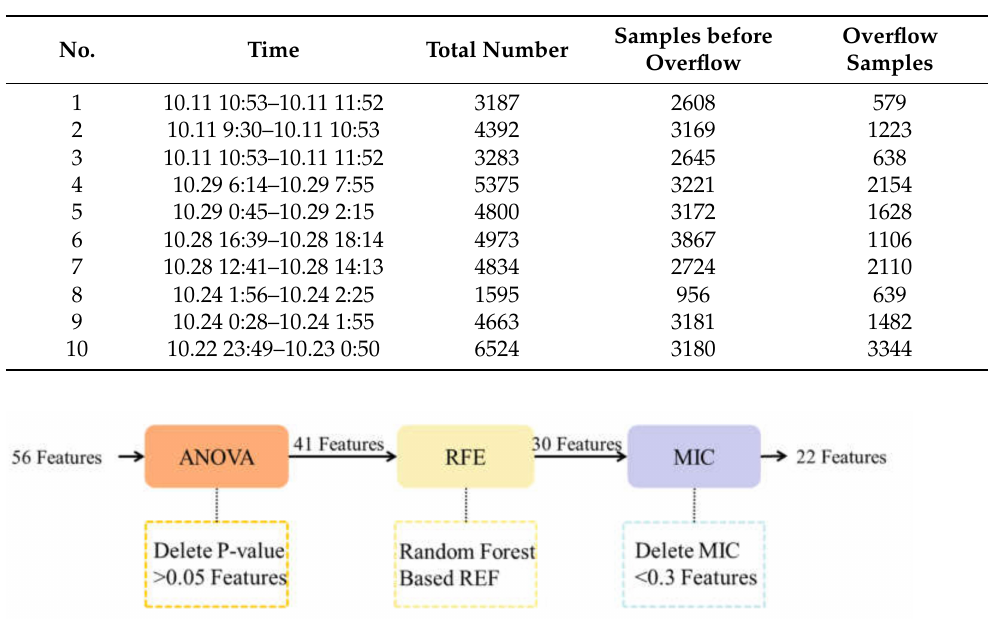
Table 1. Descriptive statistics of data.